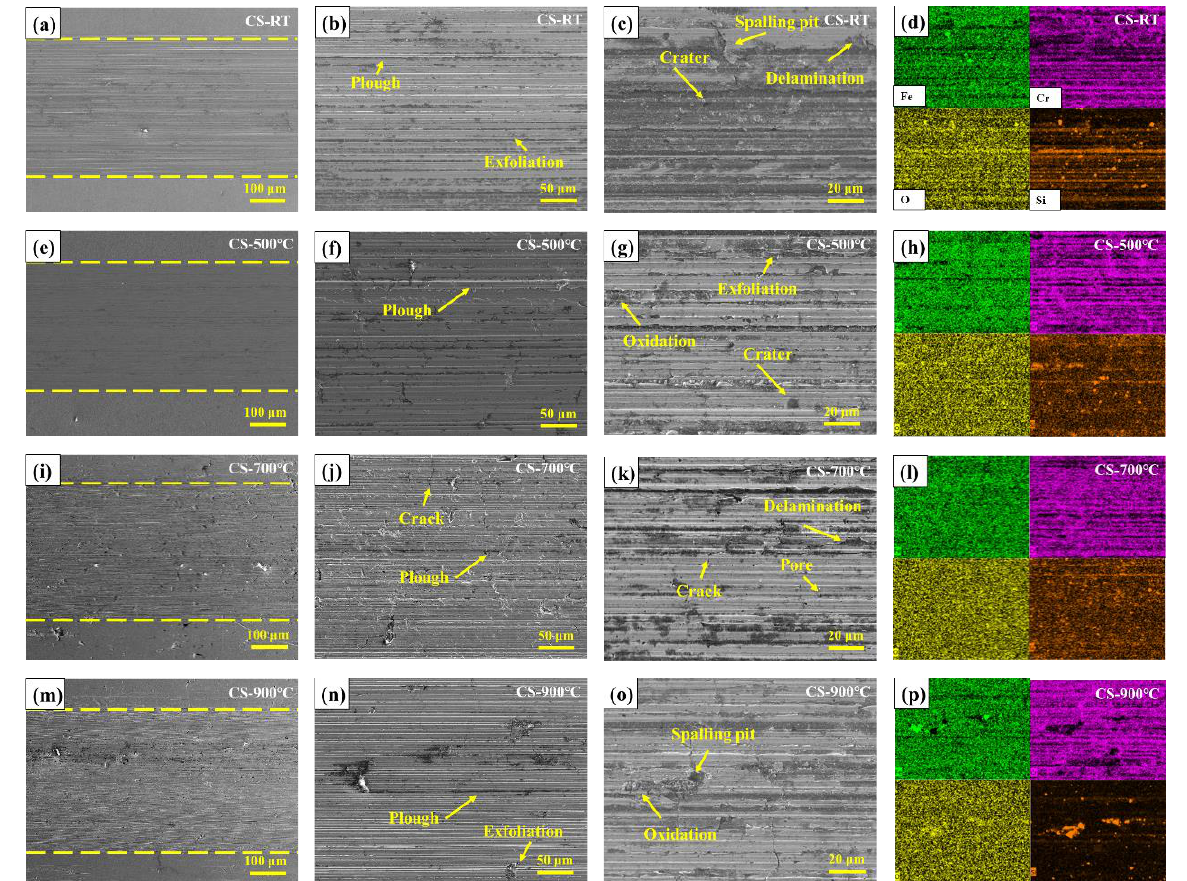
Figure 15. SEM wear morphology and EDS spectrum analysis of CS coatings under different heat- treatment conditions. ( a – d ) CS-RT coating; ( e – h ) CS-500 °C coating; ( i – l ) CS-700 °C coating; ( m – p ) treatment conditions. ( a – d ) CS-RT coating; ( e – h ) CS-500 ◦ C coating; ( i – l ) CS-700 ◦ C coating; ( m – p ) CS-900 °C coating. CS-900 ◦ C